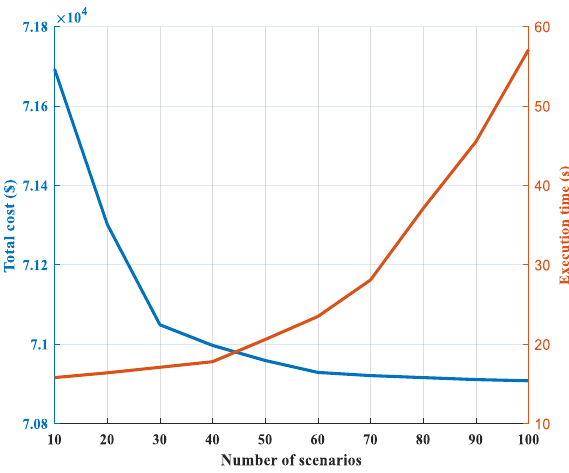
Figure 8. Performance analysis of the proposed approach regarding different number of scenarios. Table 2. Effect of correlations on economic analysis.